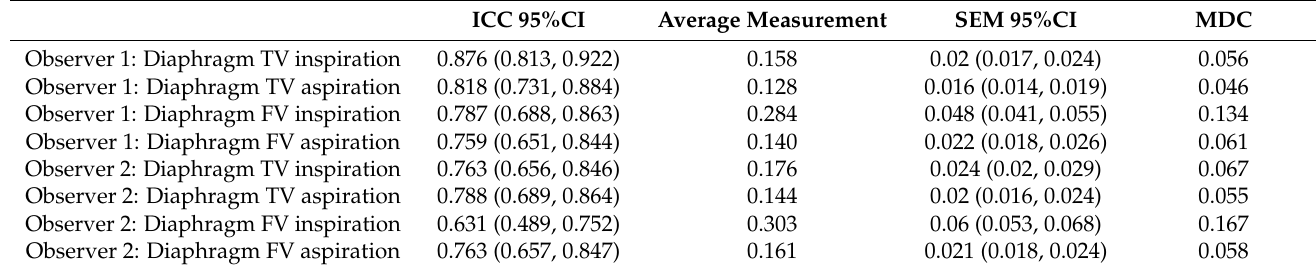
Table 1. Intra-rater reliability of thickness of the diaphragm measurements. ICC 95%CI Average Measurement SEM